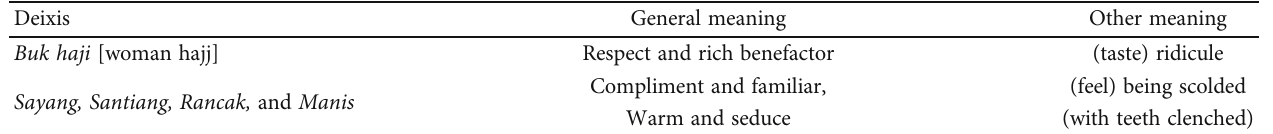
Table 7: Deixis with di ff erent meanings.